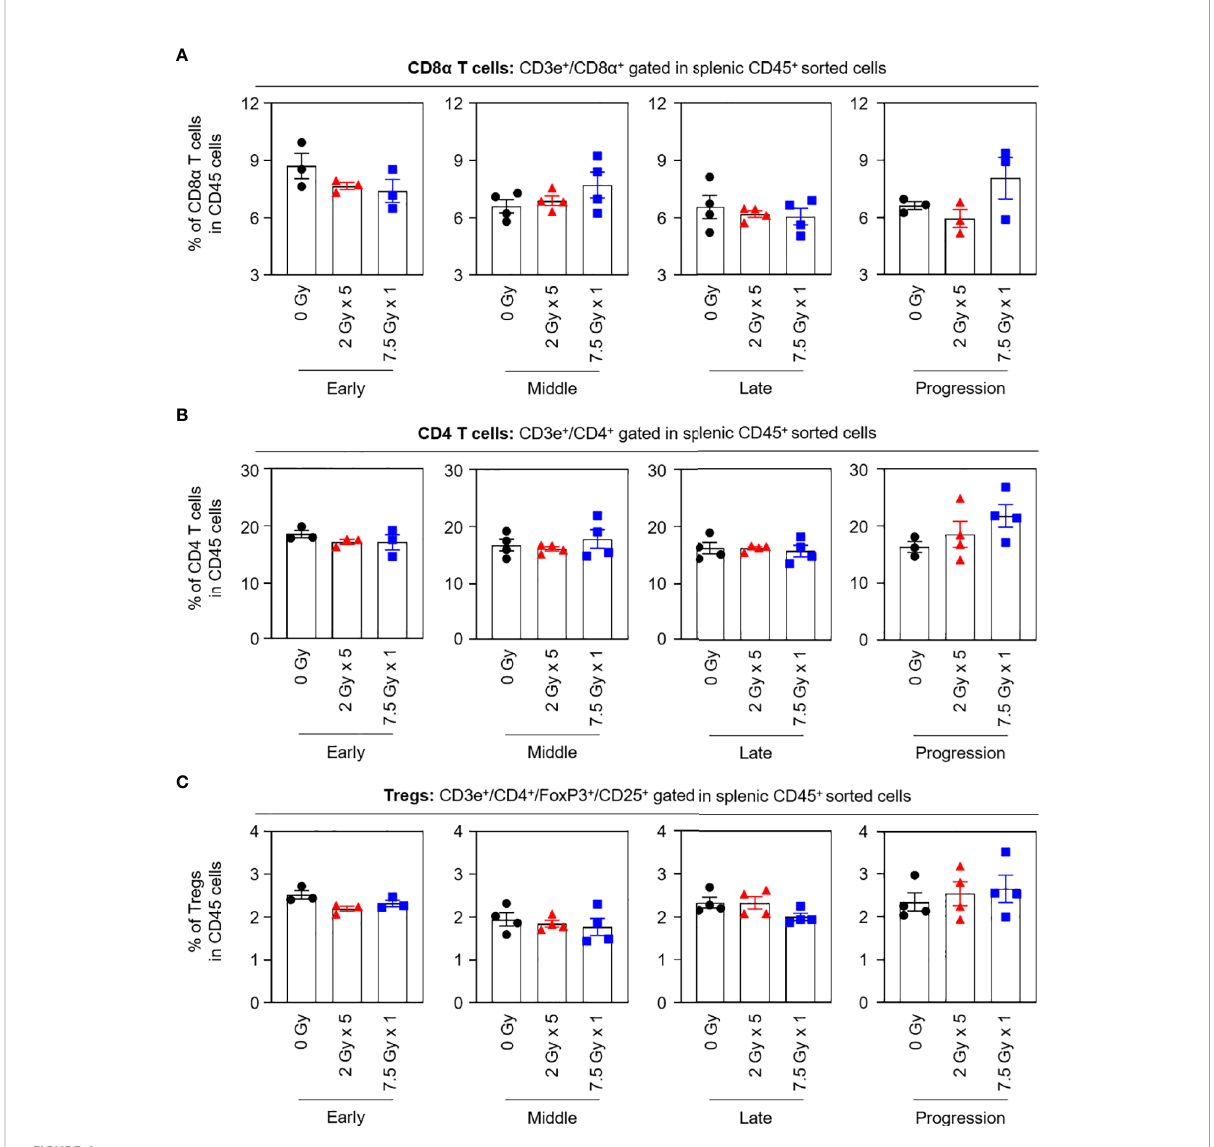
FIGURE 4 Compositions of the splenic T-cell subsets. Proportions of (A) CD8 a T, (B) CD4 T, and (C) Tregs in each time phase. These fi gures are based on the representative data obtained from at least two independent experiments. Abbreviation: Tregs, regulatory T cells; ANOVA, analysis of